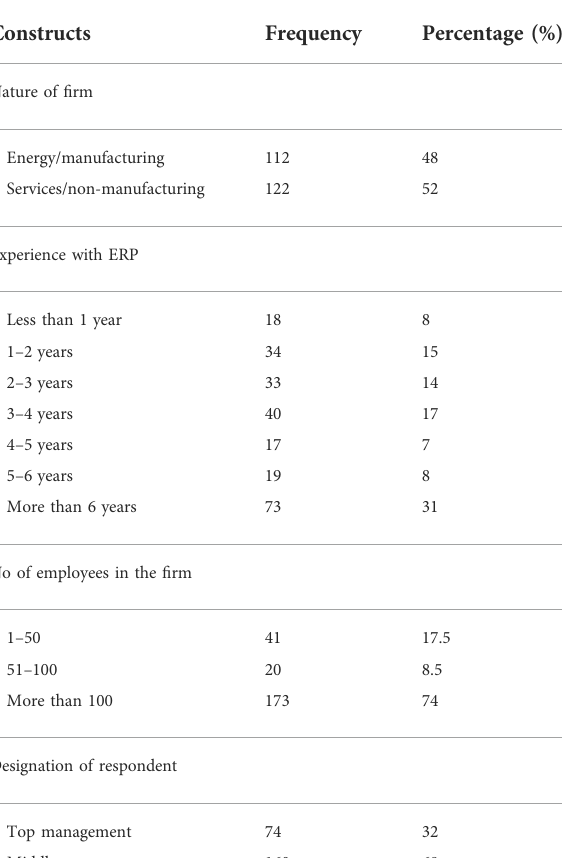
TABLE 2 Characteristics of